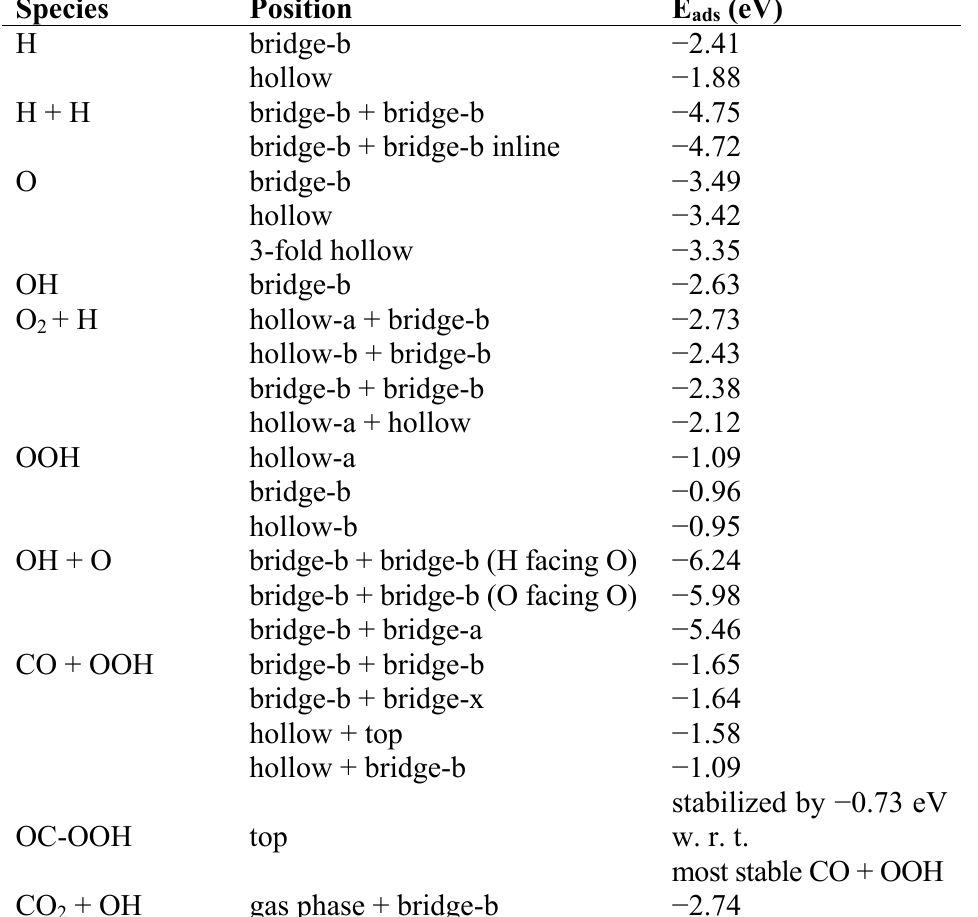
Table 4. Adsorption energy of different species on diatomic row on Au(100)-p(3 × 2).